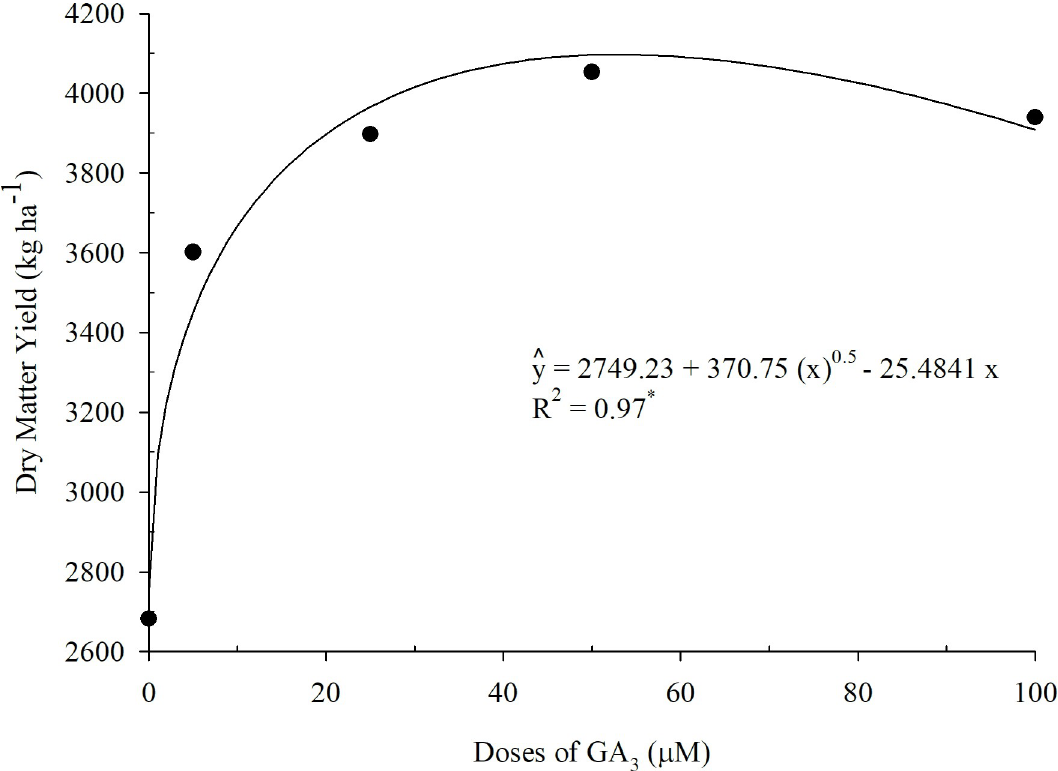
Fig 5. Tifton 85 bermudagrass dry matter yield in function of different doses of GA 3 (1st cycle).